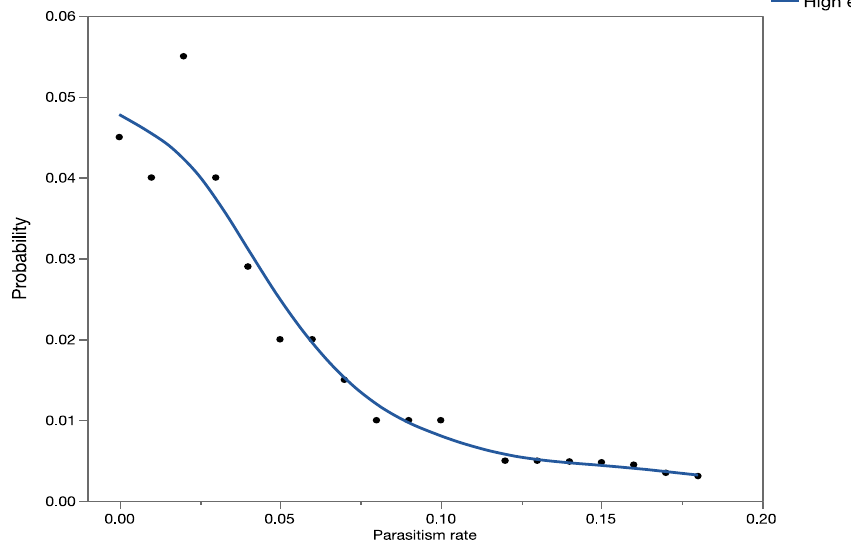
Figure 4. Forecast of all possible parasitism rates (as proportion on the x -axis) for C. marginiventris at high-elevation sites using field-collected data from retrospective studies in Hawaii.